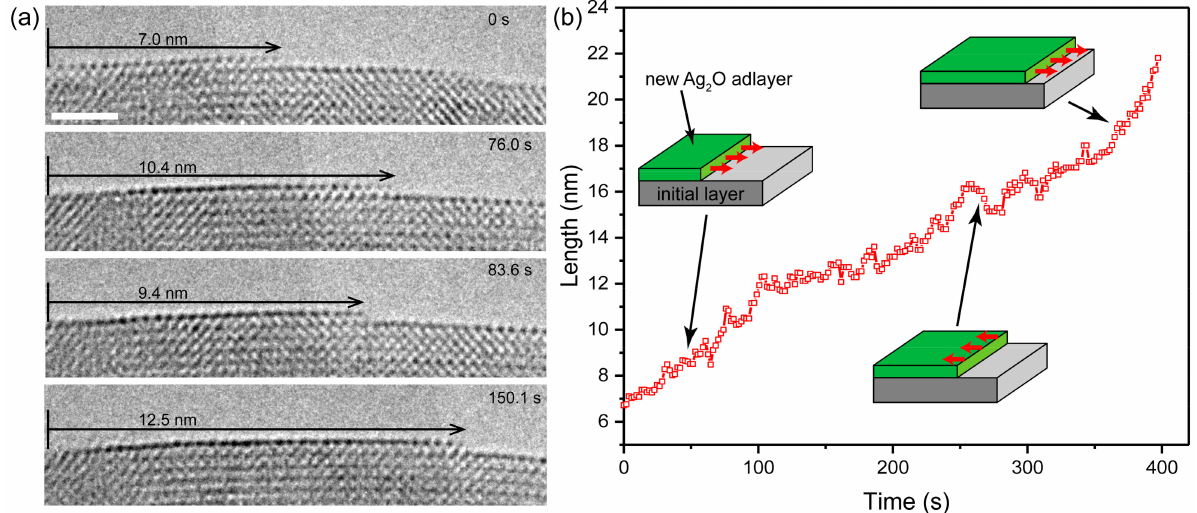
Figure 4. Oscillatory growth of oxide layer on the {110} planes ( a ) Sequences of high-resolution TEM images of the growth on the Ag 2 O (110) surface under the electron beam irradiation with a dose rate of 9700 e · Å − 2 · s − 1 . ( b ) The growth length of the oxide layer as a function of time; insets show schematically the different growth stages of the oxide layer. Scale bar at 2